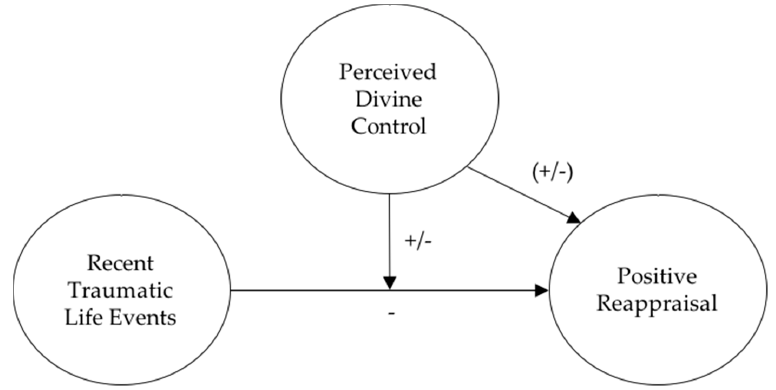
Figure 1. Stress-moderating conceptual model.